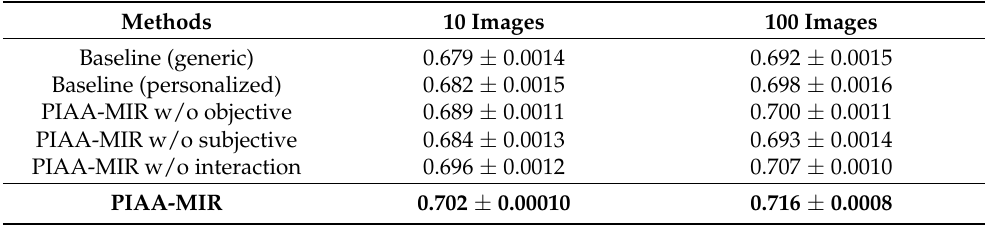
Table 4. SROCC results of our PIAA-MIR on the PAPA database [10] by eliminating different ablation modules, where the best results of fine-tuning on 10 and 100 images are shown in